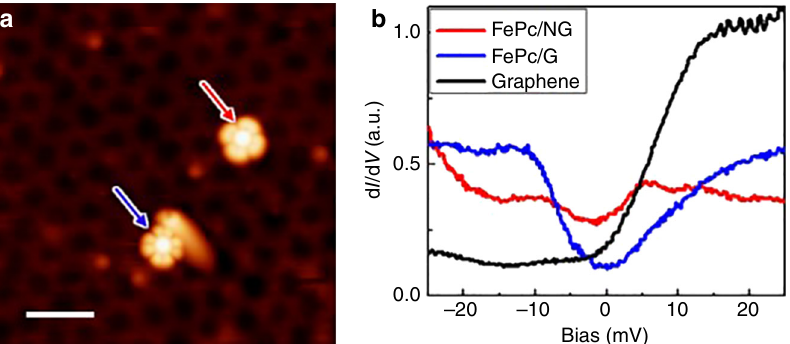
Fig. 5 Inelastic spin excitation signal on FePc molecules. a STM topography image of FePc molecules on pristine graphene (blue) and on an N-dopant (red). The FePc molecule on pristine graphene is immobilized near a graphene bubble. Image parameters: V b = − 2.0 V; I t = 10 pA . b d I /d V spectroscopy near the Fermi level on both FePc molecules adsorbed on pristine graphene (blue) and on graphitic N-dopant (red) and on pristine graphene (black) substrate for comparison. Spectroscopies were acquired at the same tunnel resistance (500 M Ω ) with voltage modulation of 0.5 mV at